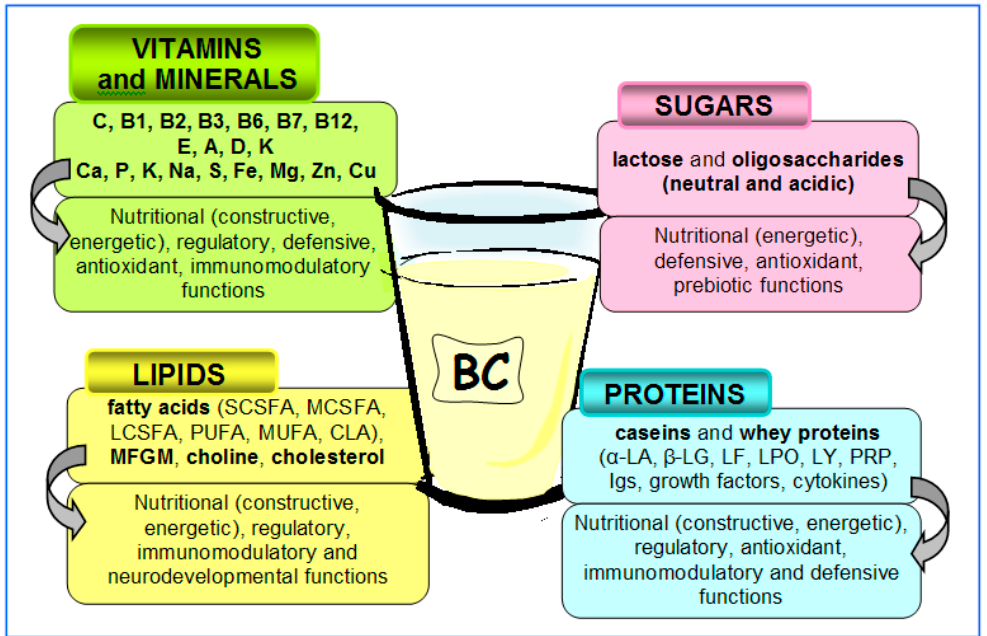
Figure 2. Selected macronutrients and micronutrients present in bovine colostrum. They ensure the nutritional value of colostrum (build up the body and provide energy), regulate metabolic pro- cesses, protect against pathogens and oxidative stress, and ensure correct development of the nerv- ous system, digestive system and physiological symbiotic microbiota. α -LA— α -lactoalbumin, β